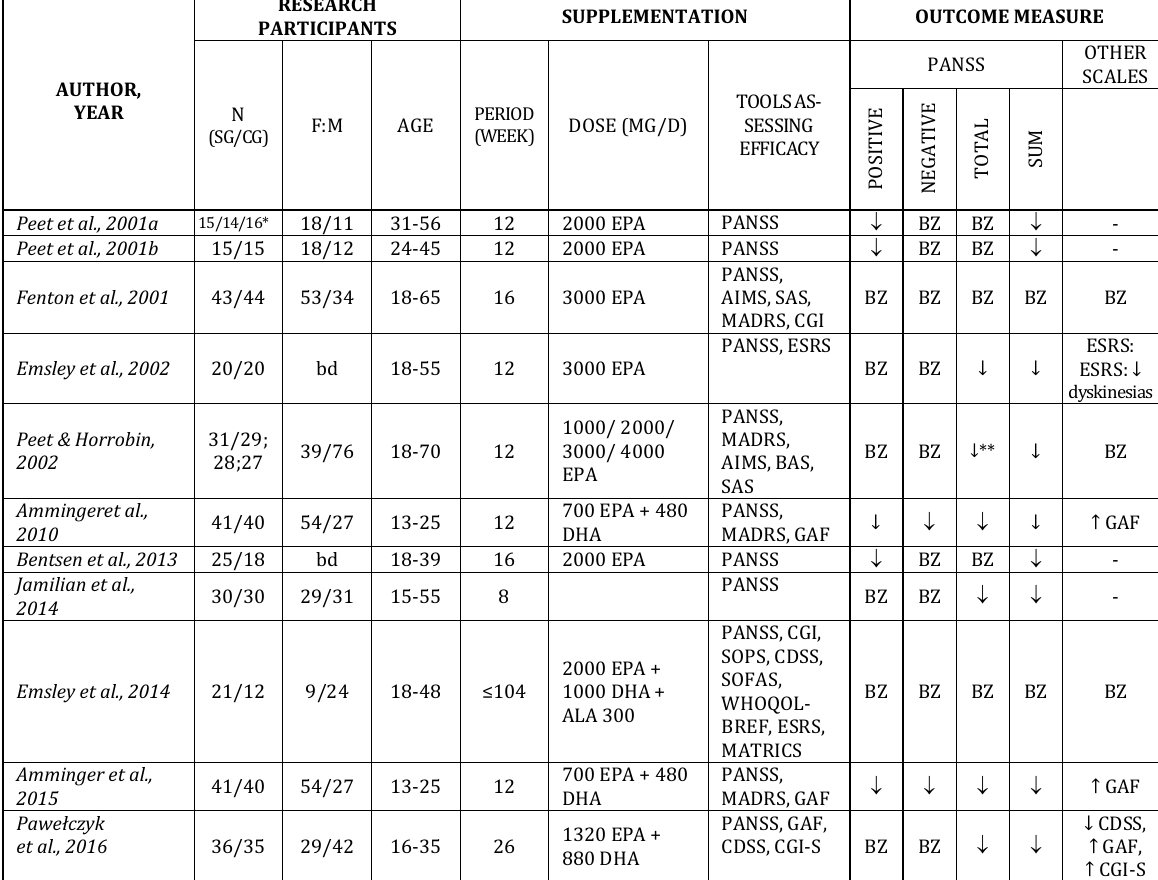
Table 1. Randomized controlled trials, double-blind (RCTs) - the efficacy of ω-3 EFAs in the treatment of schizophrenia.